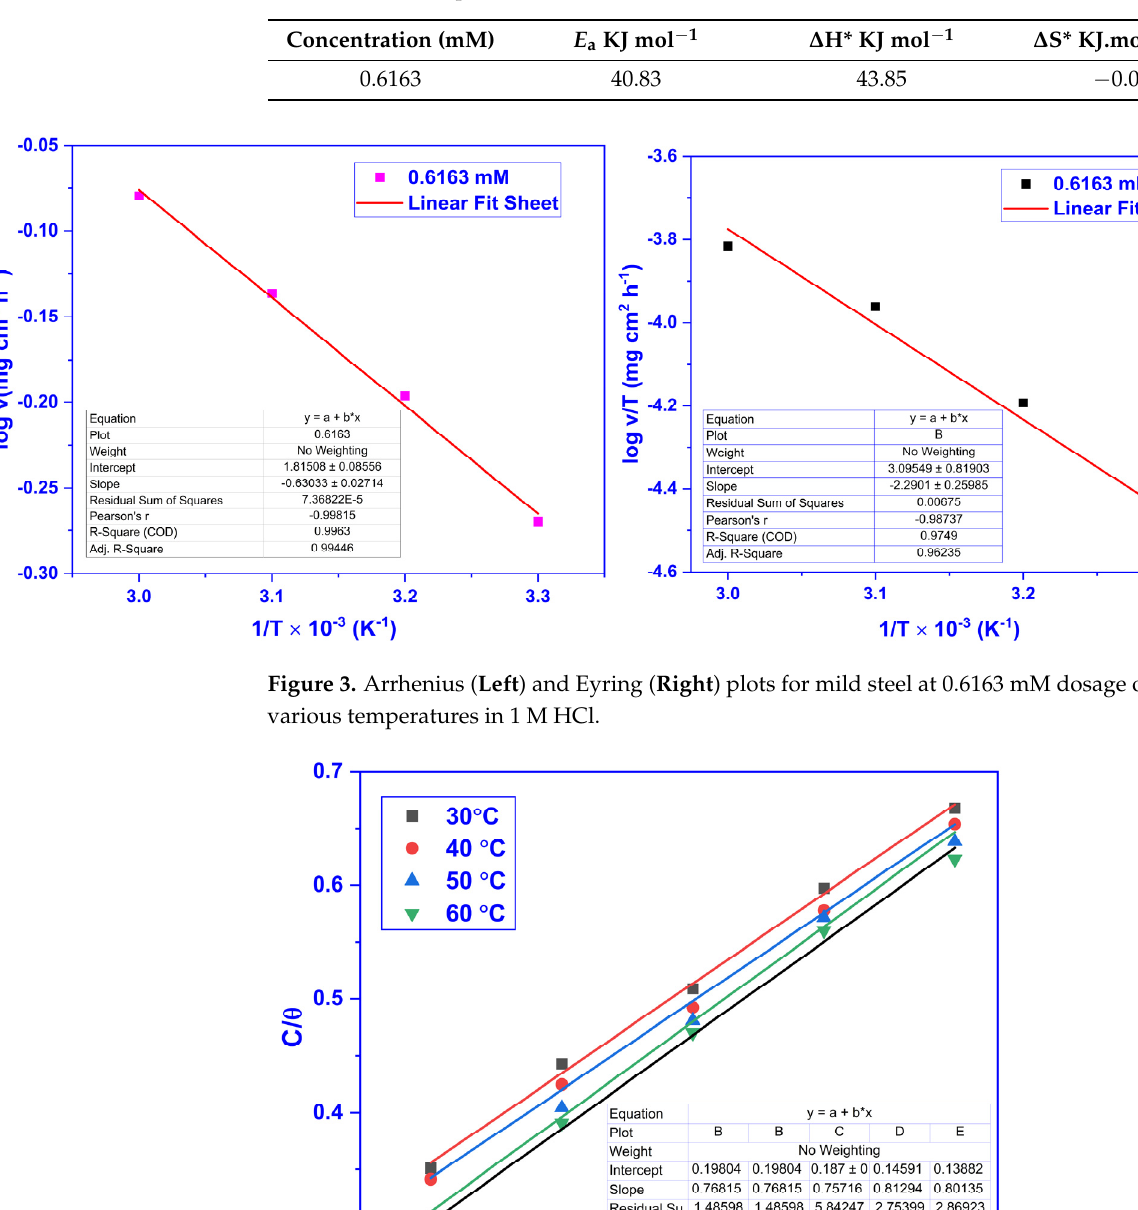
Table 3. Thermodynamic adsorption parameters in 1 M HCl for MS at various CMEA doses between 30 and 60